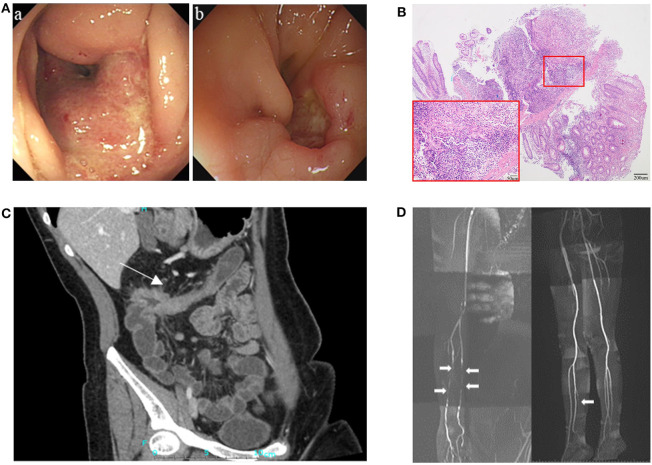
Clinical presentation of the patient. (A) Endoscopy showed ulcers and stricture in the ascending colon in August 2010 (a), and relapsing ulceration of intestinal anastomosis and stricture in transverse colon 8 years after right hemicolectomy (b). (B) Pathological examination showed intestinal transmural inflammation with an increased number of inflammatory cells infiltration, loss of crypt and hyperplasia of fibrous tissue. (C) CT enterographic (CTE) image demonstrated thickening of the wall and stricture in the colon-hepatic curvature and the proximal transverse colon (arrow). (D) Magnetic resonance angiography (MRA) showed multiple arteritis stenosis in upper and lower limbs (white arrows).